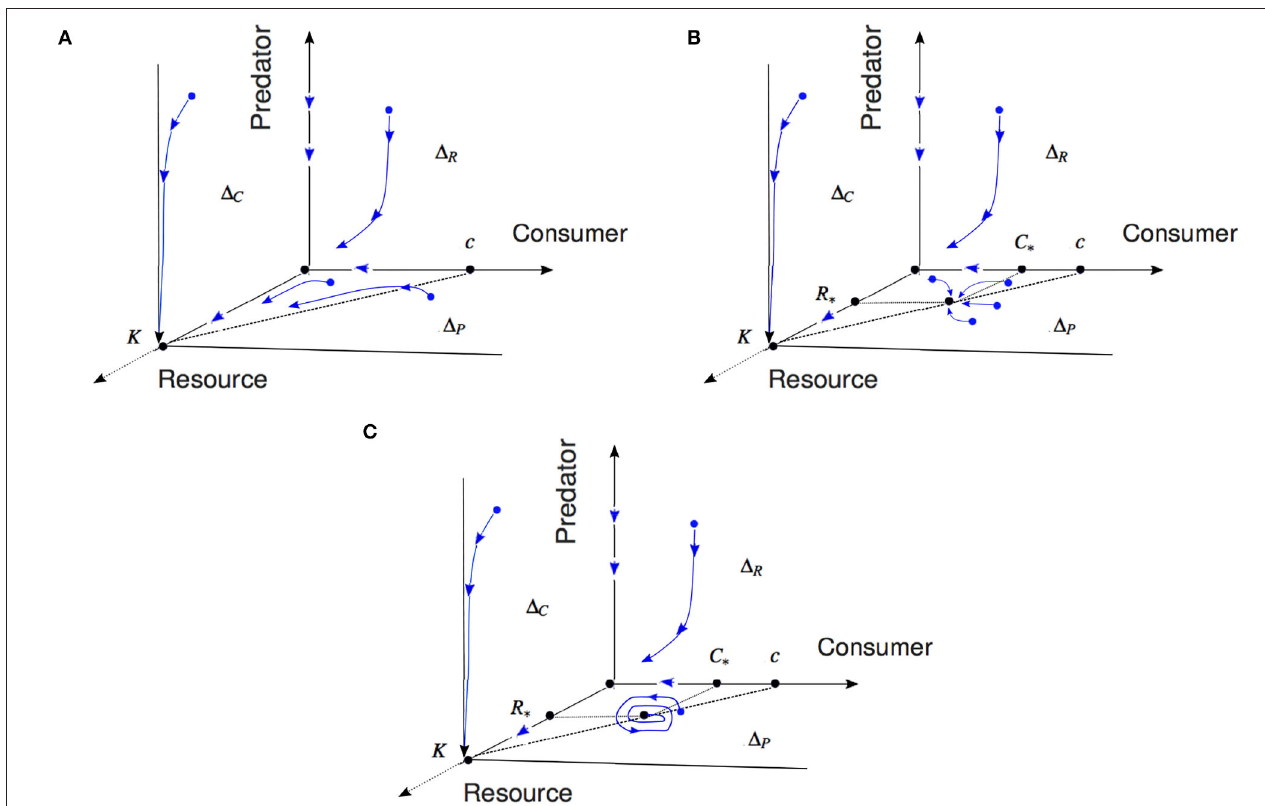
FIGURE 1 | Qualitative analysis of dynamic system. In (A) , case R C ( K ) ≤ 1, the equilibrium ( K ,0,0) attracts all trajectories starting within the R − C plane . When